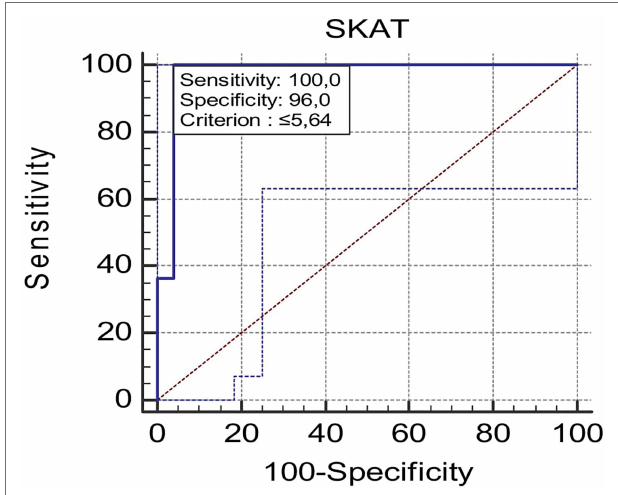
FIGURE 3 | Receiver operating characteristics curve for the SKAT between international and national karateka athletes.